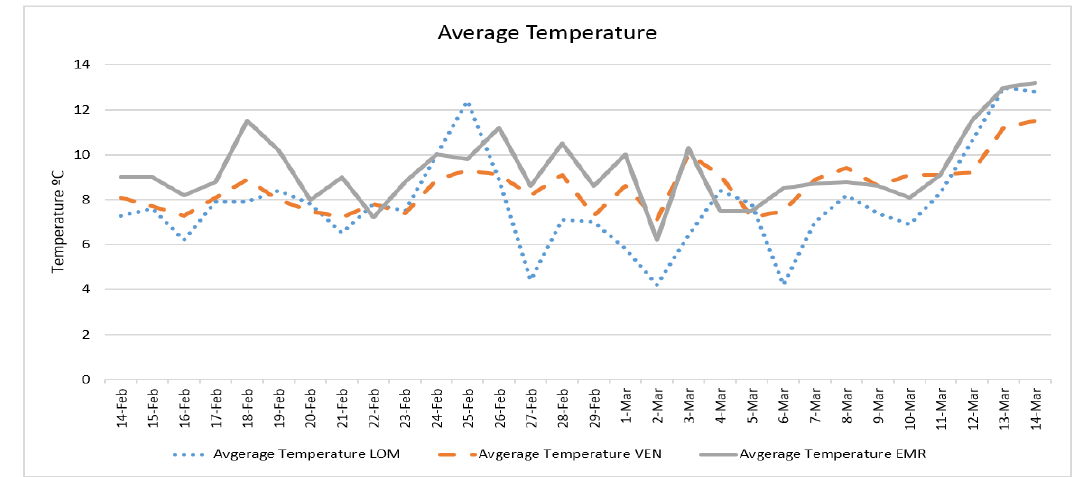
Figure 3. The daily average temperature in three case studies.